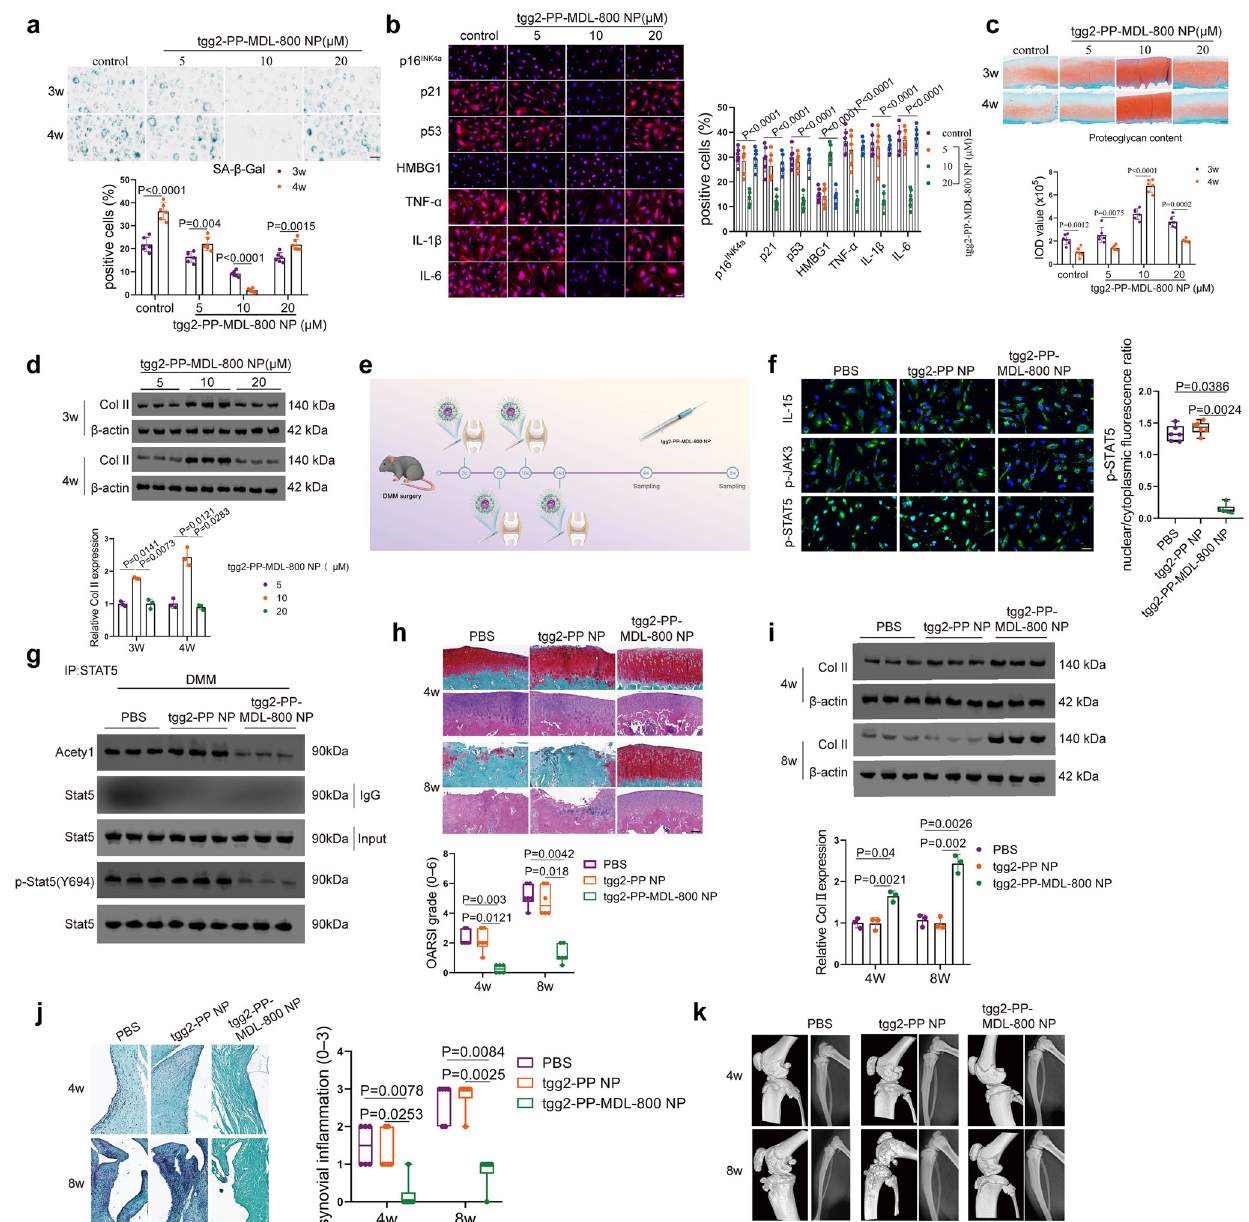
Fig. 7 | tgg2-PP-MDL-800 NP attenuates chondrocyte senescence and OA pro- gression.a SA- β -GalpositivitywasanalyzedinhumanOAchondrocytesafter3and 4 weeks of culture with tgg2-PP-MDL-800 NP or control (5, 10, or 20 µ M). n =6 independent biological replicates per group. b Representative immuno fl uorescent images of indicated markers in human OA chondrocytes after 4 weeks of culture withtgg2-PP-MDL-800NPorcontrol(5,10,or20 µ M). n =6independentbiological replicatespergroup. c ProteoglycancontentwasmeasuredbysafraninO-fastgreen staininginhumanOAcartilageexplantsafter3and4weeksofincubationwithtgg2- PP-MDL-800NP. n =6 independent biologicalreplicatespergroup. d Western blot were performed to determine the Col II expression level at 3 and 4 weeks. n =3 independentbiologicalreplicatespergroup. e Overviewoftheexperimentalset-up with injections of PBS, tgg2-PP NP or tgg2-PP-MDL-800 NP. f Representative immuno fl uorescent images of IL-15, p-JAK3, and p-STAT5 levels in these chon- drocytes from different treatment groups. n =6 independent biological replicates per group. g Western blot analysis of protein levels of Acetyl, p-Stat5 (Y694), and Stat5. n =3 independent biological replicates per group. h , i At 4 and 8 weeks,